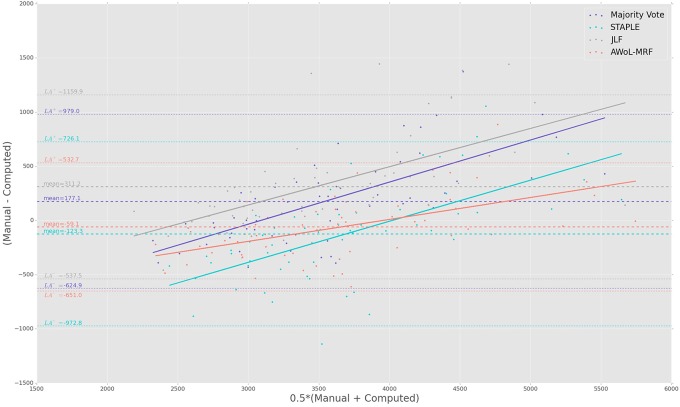
Experiment I Bland-Altman Analysis: Comparison between computed and manual volumes (in mm3) for single parameter configuration of 9 atlases and 19 templates. The overall mean difference in volume, and limits of agreement (LA+/LA−: 1.96 SD) are shown by dashed horizontal lines. Linear fit lines are shown for each method. Note that the points above the mean difference indicate underestimation of the volume with respect to the manual volume, and vice versa.